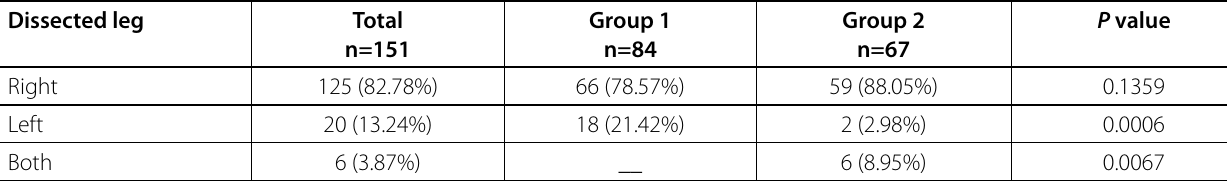
Table 2. Leg selected for intraoperative saphenous